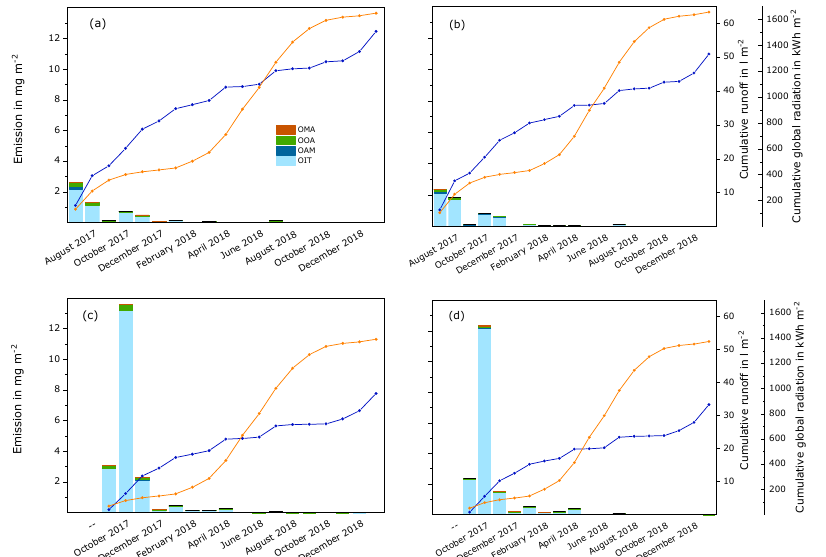
Figure 4. Monthly emissions of OIT and transformation products from a white and a red paint film during semi-field experiments that were started in July 2017 (experiment A) and September 2017 (experiment B). The columns represent the substances that were detected in runoff samples per month. The blue curves show the cumulated volume of runoff samples per surface area for each experiment. The orange curves show the cumulative global radiation during the experiment. ( a ) Experiment A, white paint; ( b ) experiment A, red paint; ( c ) experiment B, white paint; ( d ) experiment B, red